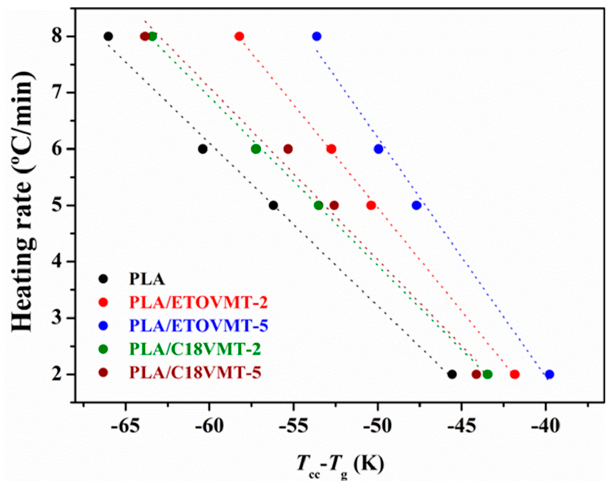
Figure 8. Plots of heating rate as a function of the difference between the cold crystallization and glass transition temperatures for PLA and PLA/VMT nanocomposites.